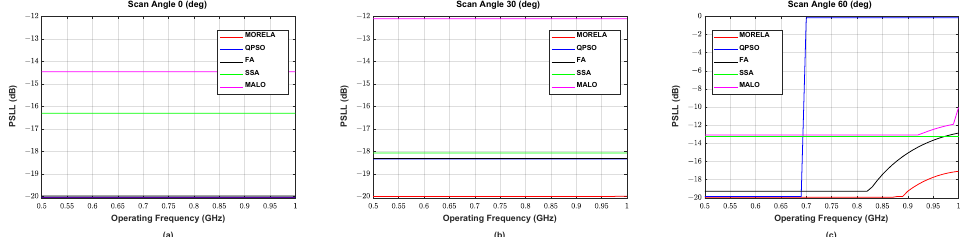
Figure 7. The SLL performance of symmetric NUSLA in the case for ( a ) θ 0 = 0°, ( b ) θ 0 = 30°, and ( c ) θ 0 = 60°.